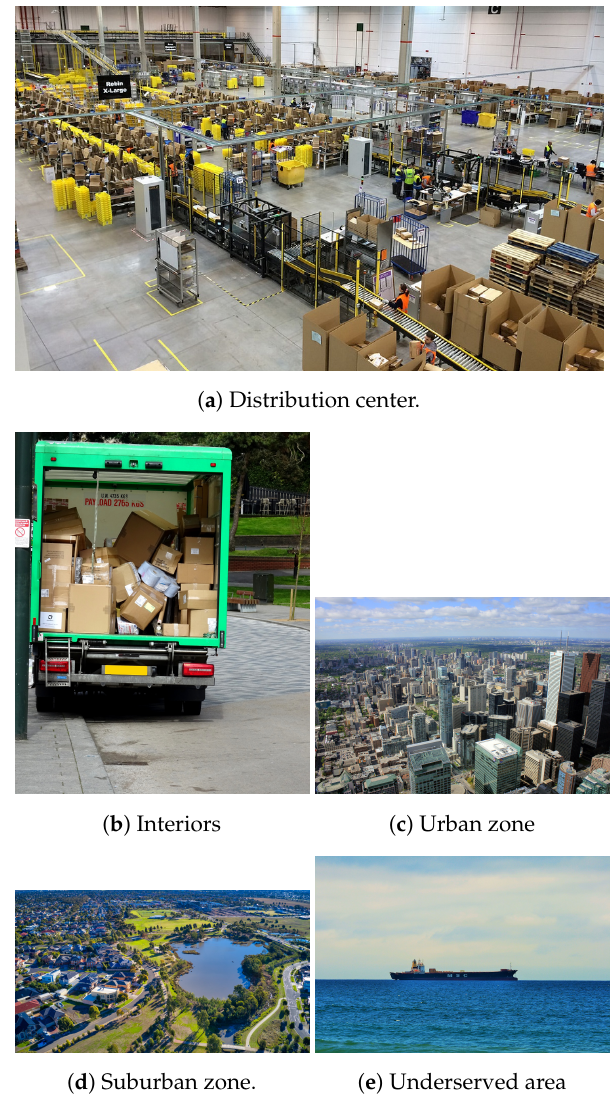
Figure 4. Typical environments for